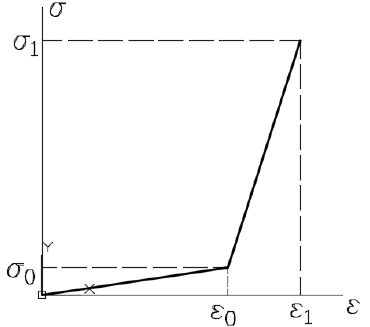
Fig. 20. Stress-strain curve 𝜎(𝜀) of the SGS